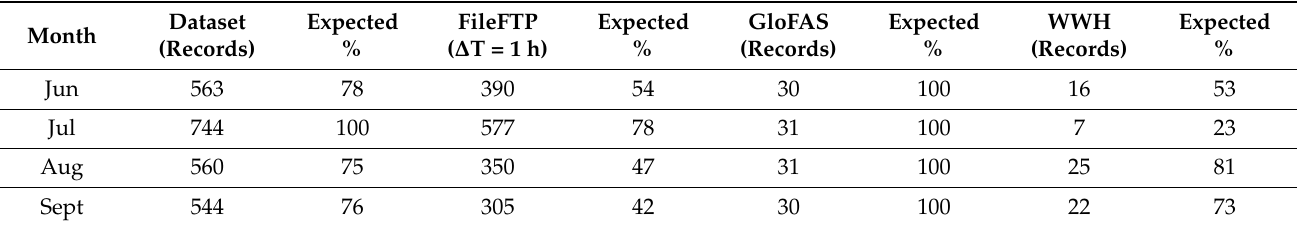
Table 6. Bossey Bangou station: dataset consistency, performance in FTP data transmission, and forecast download.